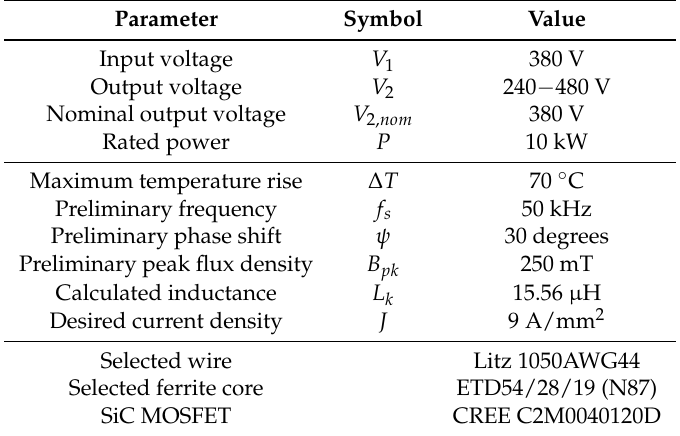
Table 1. Specification and preliminary parameters.